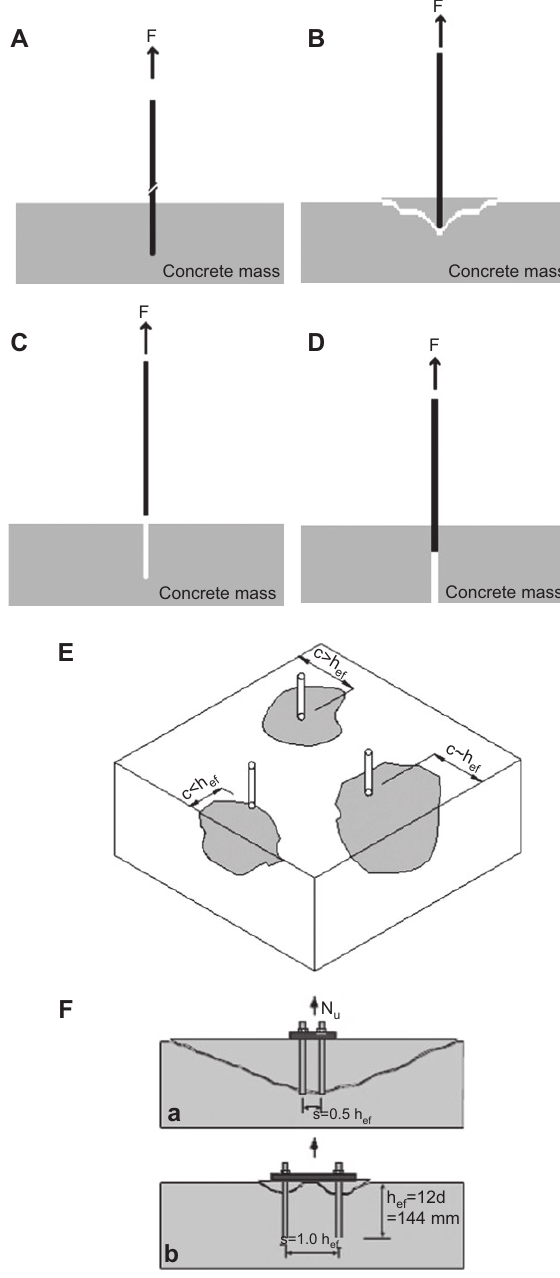
Figure 2 Failure modes of anchors in tensile loading. (A) Failure of anchor steel. (B) Concrete cone failure. (C) Pullout of the anchor. (D) Splitting failure. (E) Edge failures. (F) Spacing failures for group